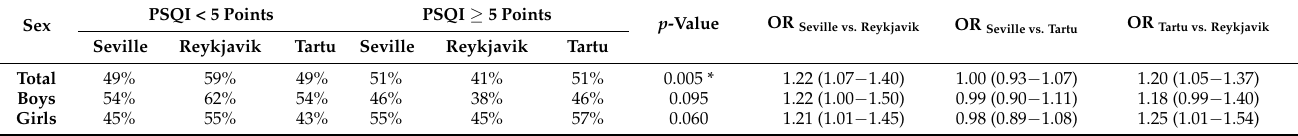
Table 4. Probability of having poor sleep quality in boys and girls by cities.